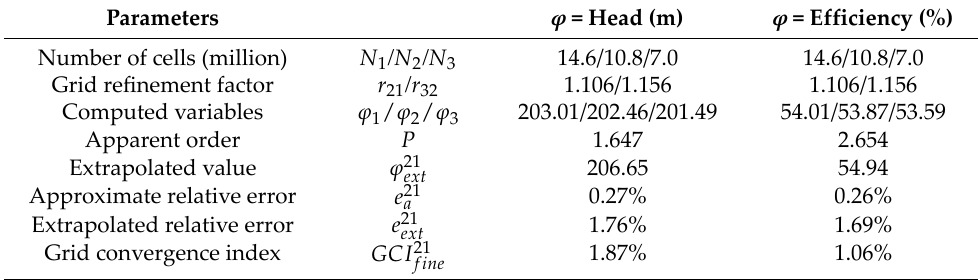
Figure 4. Mesh model and local encrypted mesh of Multi‑stage PAT. ( a ) global mesh, ( b ) local detail. The discretized error data of the grids utilized for the calculation were obtained to an‑ alyze the error verification of the grids, as demonstrated in Table 5. N 1 /N 2 /N 3 corresponds to different grids of the total number of grids, respectively. φ 1 / φ 2 / φ 3 are the parameters of the flow characteristics within the multi‑stage PAT under the corresponding grids, respec‑ tively. The numerical errors of the head coefficient and the efficiency coefficient are 1.87% and 1.06%, respectively. The discretization error of the grids is small enough to ensure the accuracy of the calculation. Table 5. Analysis of grid